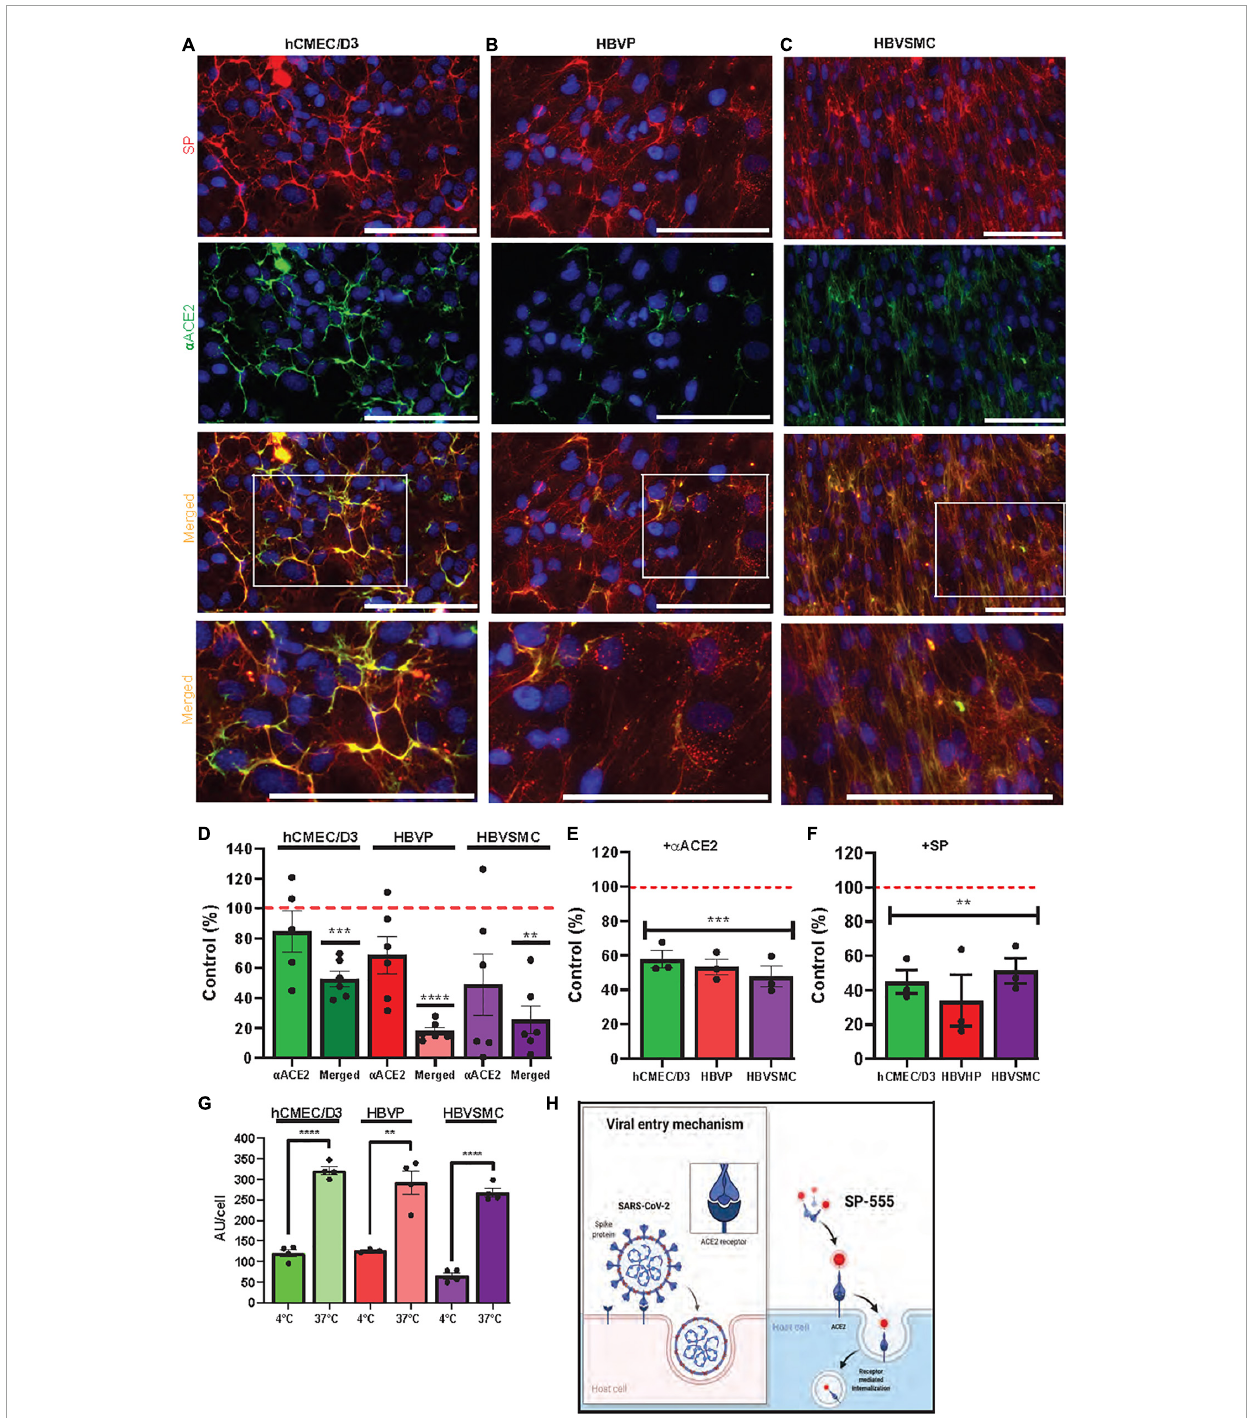
FIGURE3 ACE2 mediates SARS-CoV-2/SP uptake in cerebrovascular cells . (A–C) SP-555 and anti-human ACE2 antibody ( α ACE2-488) co-localized on each of the cell types, hCMEC/D3 (A) , HBVP (B) , and HBVSMC (C) . Lowest row is the magnified image of the white boxed area above. (D) Intensities of α ACE2 and merged SP/ α ACE2 (yellow) were expressed as a percentage of SP-555 AU (controls were the intensities of SP-555 cellular binding (all values were corrected as per cell). (E) Excess unlabeled α ACE2 displaced SP-555 binding, which confirms the data in panel (D) . (F) Excess unlabeled SP (self-competition) displaced SP-555 uptake. Controls were the intensities of SP-555 cellular binding without excess unlabeled α ACE2 (panel E ) or unlabeled SP (panel F ). (G) SP-555 receptor binding (4 ◦ C) considerable less than that at 37 ◦ C. (H) Schematic diagram showing that SP-555 mimics SARS-CoV-2 binding to ACE2. Adapted from “Proposed Therapeutic Treatments for COVID-19 Targeting Viral Entry Mechanism by www.biorender.com (2021). Retrieved from https://app.biorender.com/biorender-templates. Red dashed line is the control levels (100%). Values are mean ± SEM. N = number of well use (each data point). Statistically analyzed was by analysis of variance (ANOVA) followed by Tukey post-hoc test. * P < 0.05, ** P < 0.01, and *** P < 0.001 and **** P < 0.0001. GraphPad Prism version 9.2.0 was used. Scale bar = 100 µ m. Supplementary Figures 1 , 3